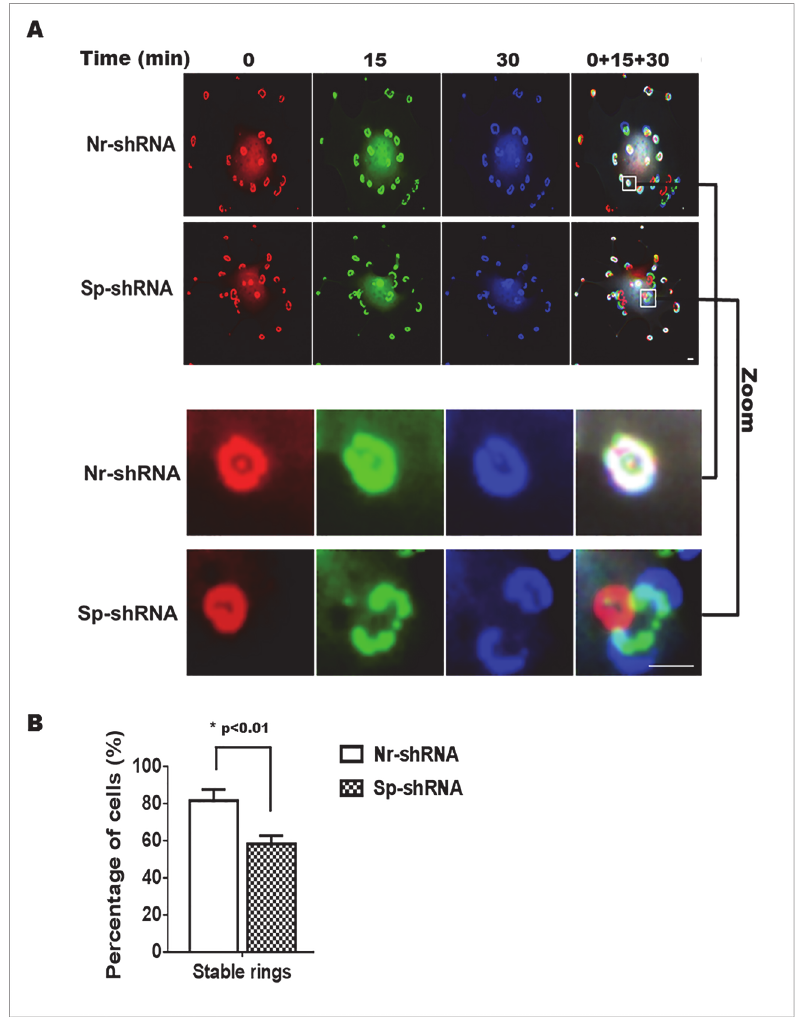
Fig 7. Knockdown of α II-spectrin stimulates the formation of hyperdynamic invadosome rings. SrcY527F-MEF cells were co-transfected with plasmid encoding an irrelevant shRNA (Nr-shRNA) or a shRNA targeting α II-spectrin (Sp-shRNA) and Ruby-LifeAct to follow invadosome dynamics. (A) Spectrin- depleted cells present hyperdynamic invadosome rings as showed by video microscopy analysis. Images taken at three different times (0, 15 and 30 min) and pseudo colored in red, green and blue revealed stable invadosome by white colored structures while dynamic invadosomes are not at the same position in these three different times. (B) In the control cells, a majority of cells presents stable invadosome rings (85%) over the 30 min observation, while only 15% of them change (dynamic movement and disorganization) over this period. On the contrary, spectrin depletion increases the percentage of cells with hyperdynamic invadosome rings over this period of observation (40%) and consequently decreases the global stability of invadosome rings (60%). The dynamics of invadosomes was analyzed in 30 to 40 cells per condition in three different experiments. Scale bar: 5 μ